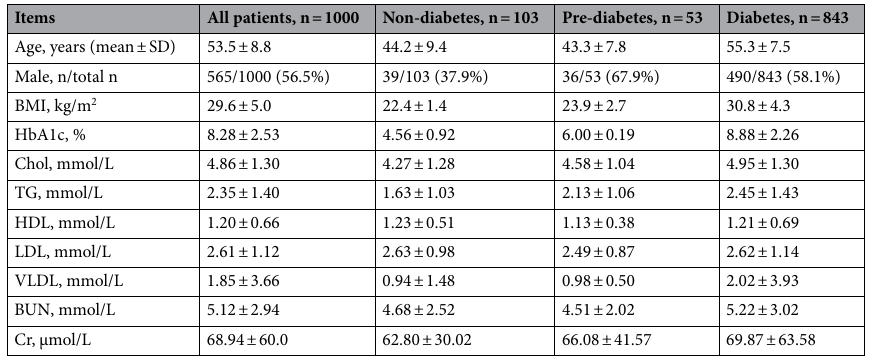
Table 1. Data and patients characteristics. n number, Cr creatinine, Chol cholesterol, TG triglyceride, BMI body mass